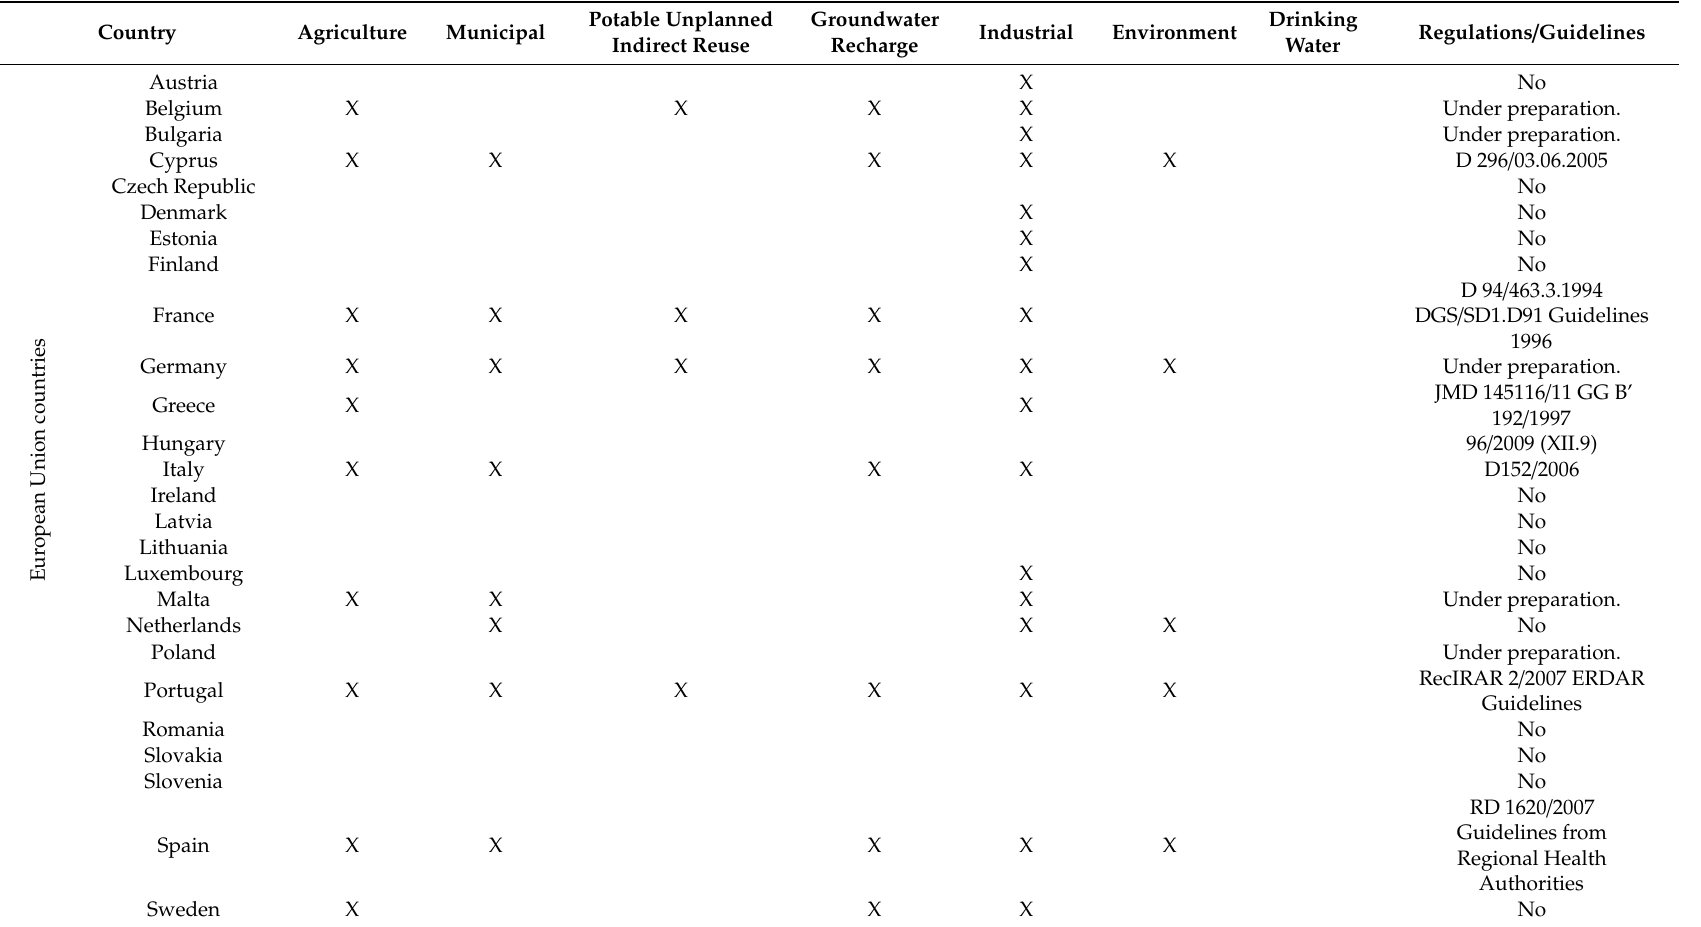
Table 1. Legislation regarding the reuse of reclaimed water for various purposes in the di ff erent countries of the European Union (EU) (Adaptation from [50]) and outside of the European Union. X: destination for reclaimed wastewater regulated in the legislation.